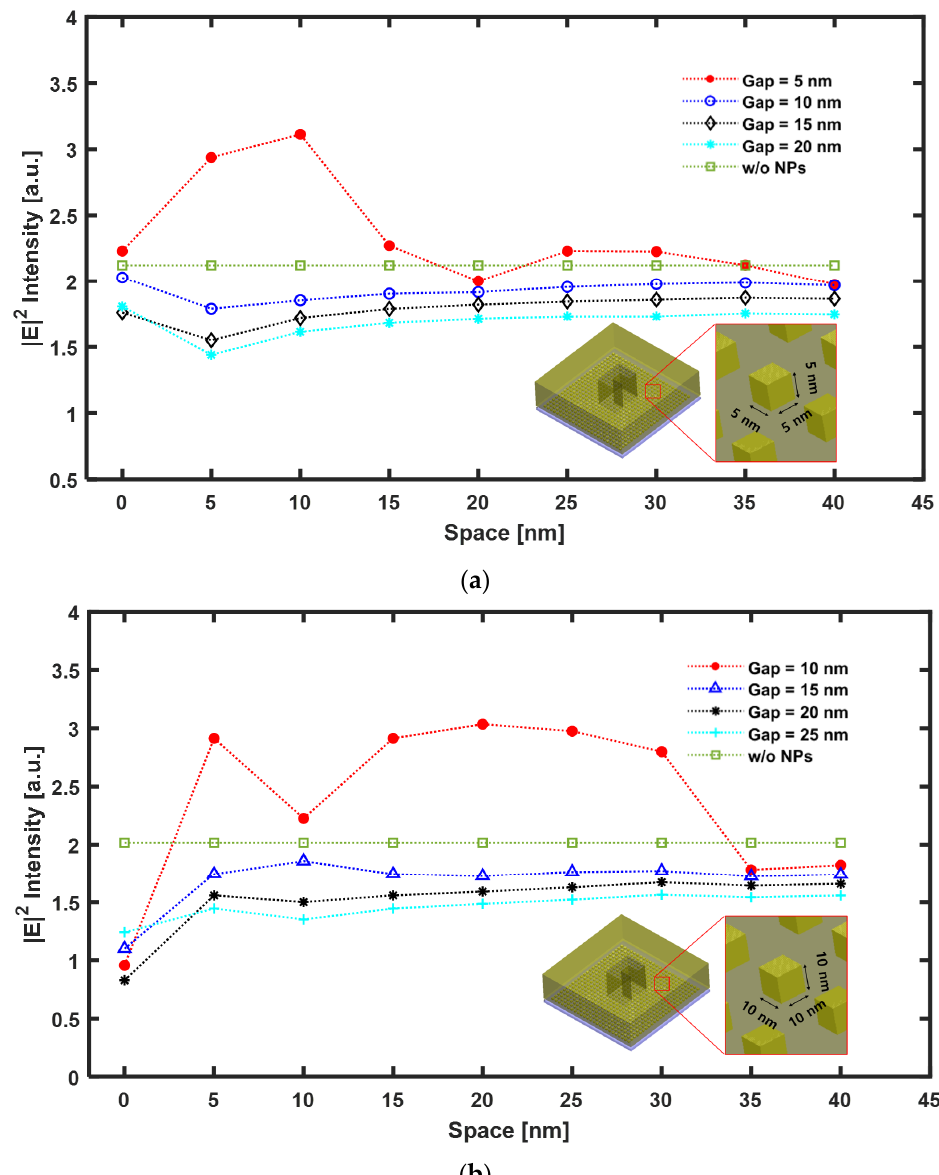
Figure 8. The calculated maximum | E | 2 intensity from the bottom surface of the ZnS-SiO 2 layer: ( a ) The size of Au NP was 5 nm × 5 nm × 5 nm; ( b ) The size of Au NP was 10 nm × 10 nm × 10